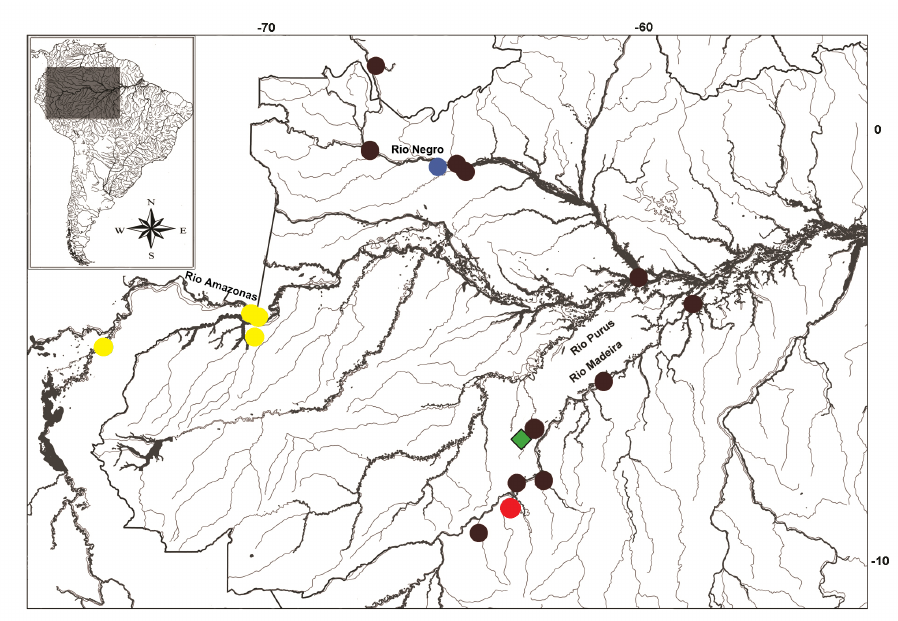
FIGURE 8 | Map of South America with a close-up of the upper and central portions of the Amazon basin, Brazil, illustrating the distribution of the five species of Priocharax : P. britzi described herein from the rio Purus basin (green losangle), P. varii (red dot), P. ariel (black dots), P. nanus (blue dot), and P. pygmaeus (yellow dots). Colors are the same as in the Fig. 7. Some dots may represent more than one